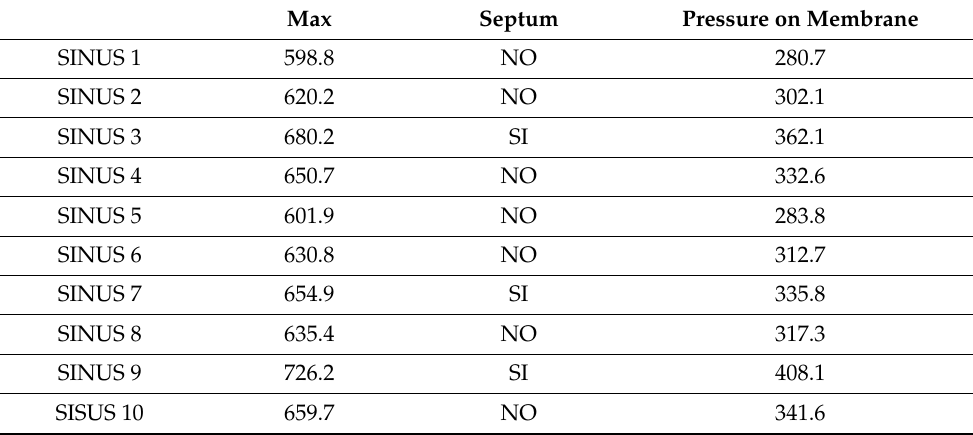
Table 4. Pressure values in mmHg.